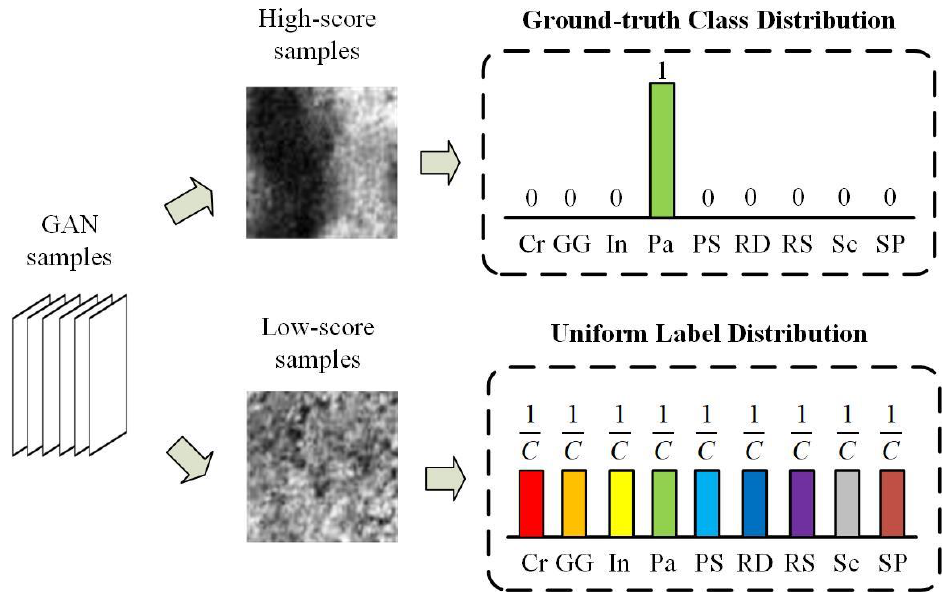
Figure 3. The label distributions for different generated samples.